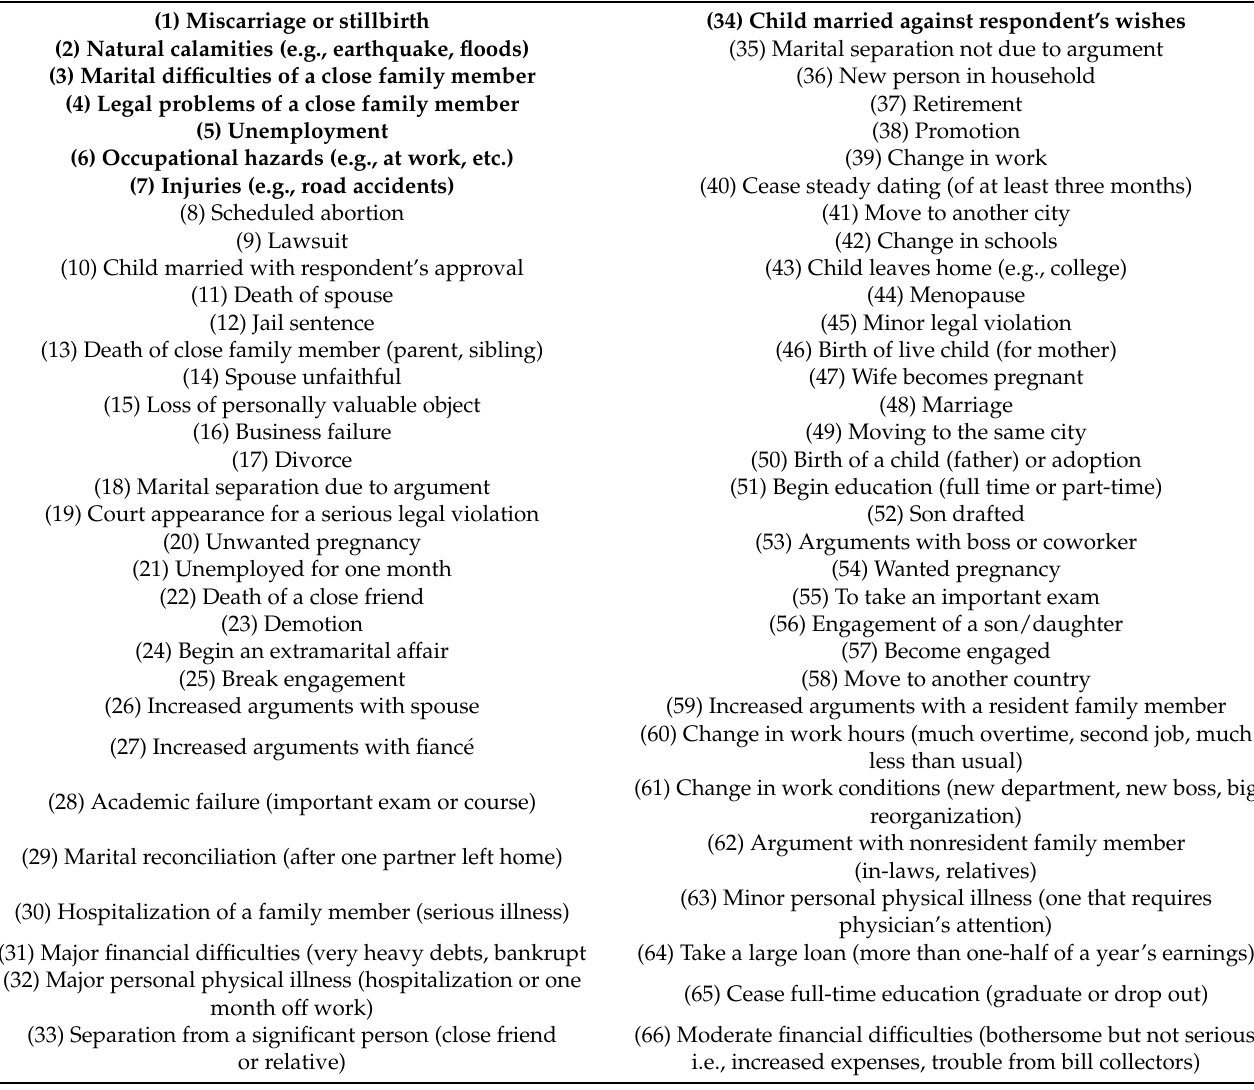
Table 1. Adaptation of the Paykel Events Scale (Paykel, 1971